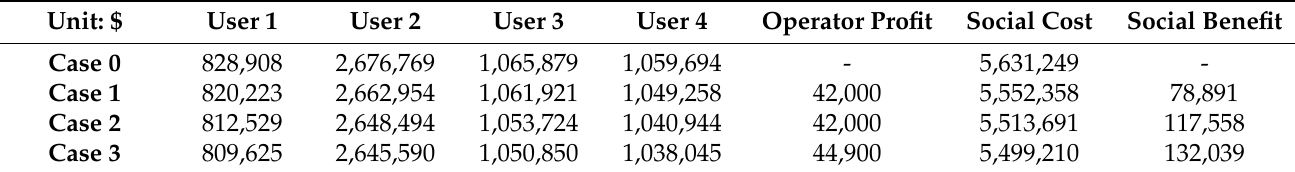
Table 3. Yearly costs of users, profit of the operator, social costs and social benefits for each